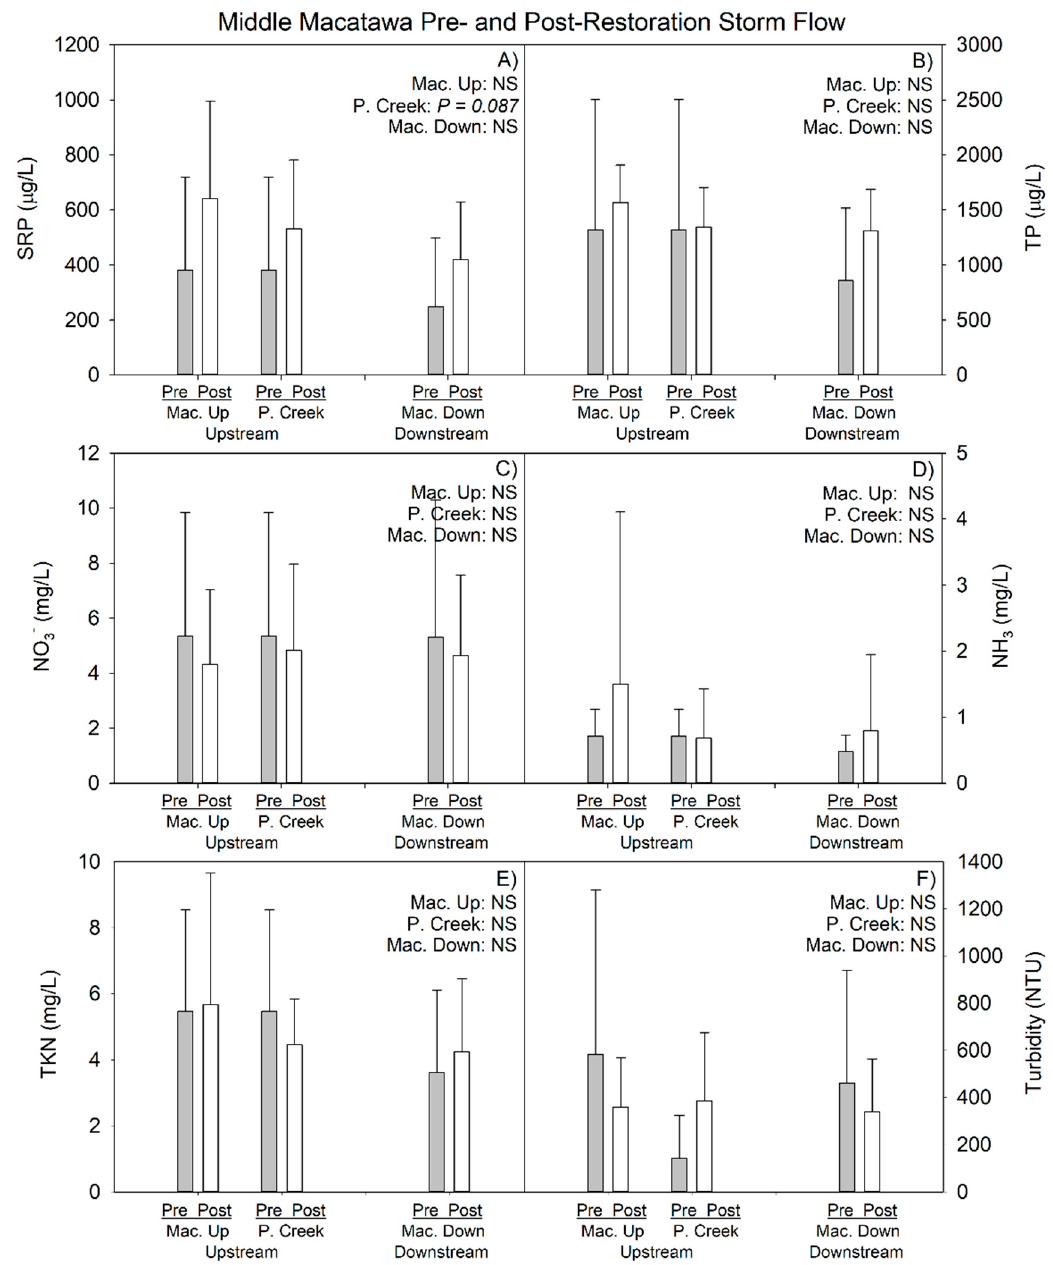
Figure 6. Mean (1 SD) Middle Macatawa pre- and postrestoration nutrient comparison at storm flow as of 2017 sampling year. p -values in top left corner of each panel represent pre- vs. postrestoration statistical analysis within each site. Mac. Up = Macatawa Upstream site; P. Creek = Peters Creek; Mac. Down = Macatawa Downstream site. See Figure 1B for site locations.